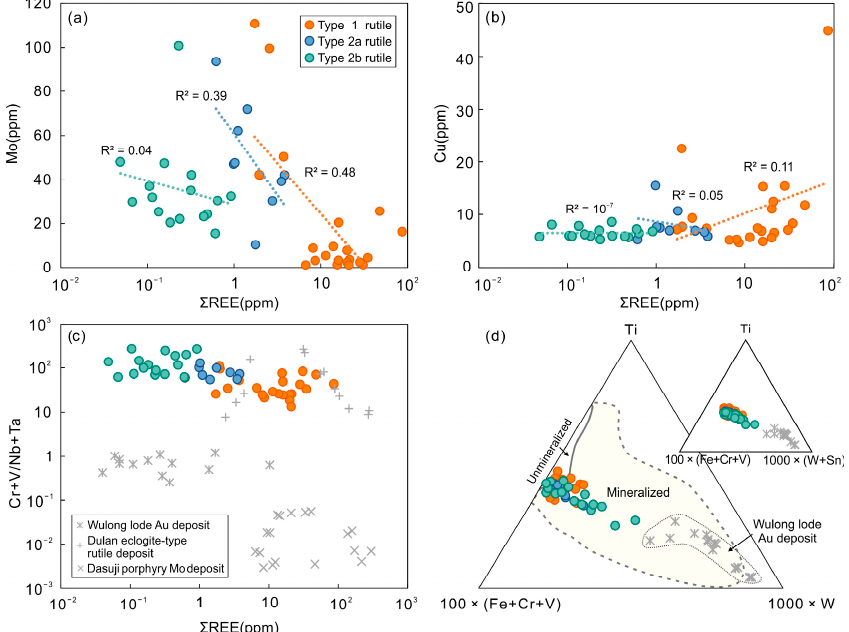
Figure 8. ( a ) Correlation between REE and Mo in rutile. ( b ) Correlation between REE and Cu in rutile. ( c ) Cr + V/Nb + Ta versus sum REE in rutile. ( d ) Ti-100 × (Fe + Cr + V) − 1000 × W ternary diagram allowing to compare the composition of rutile in Tuwu with those from the literature [16].